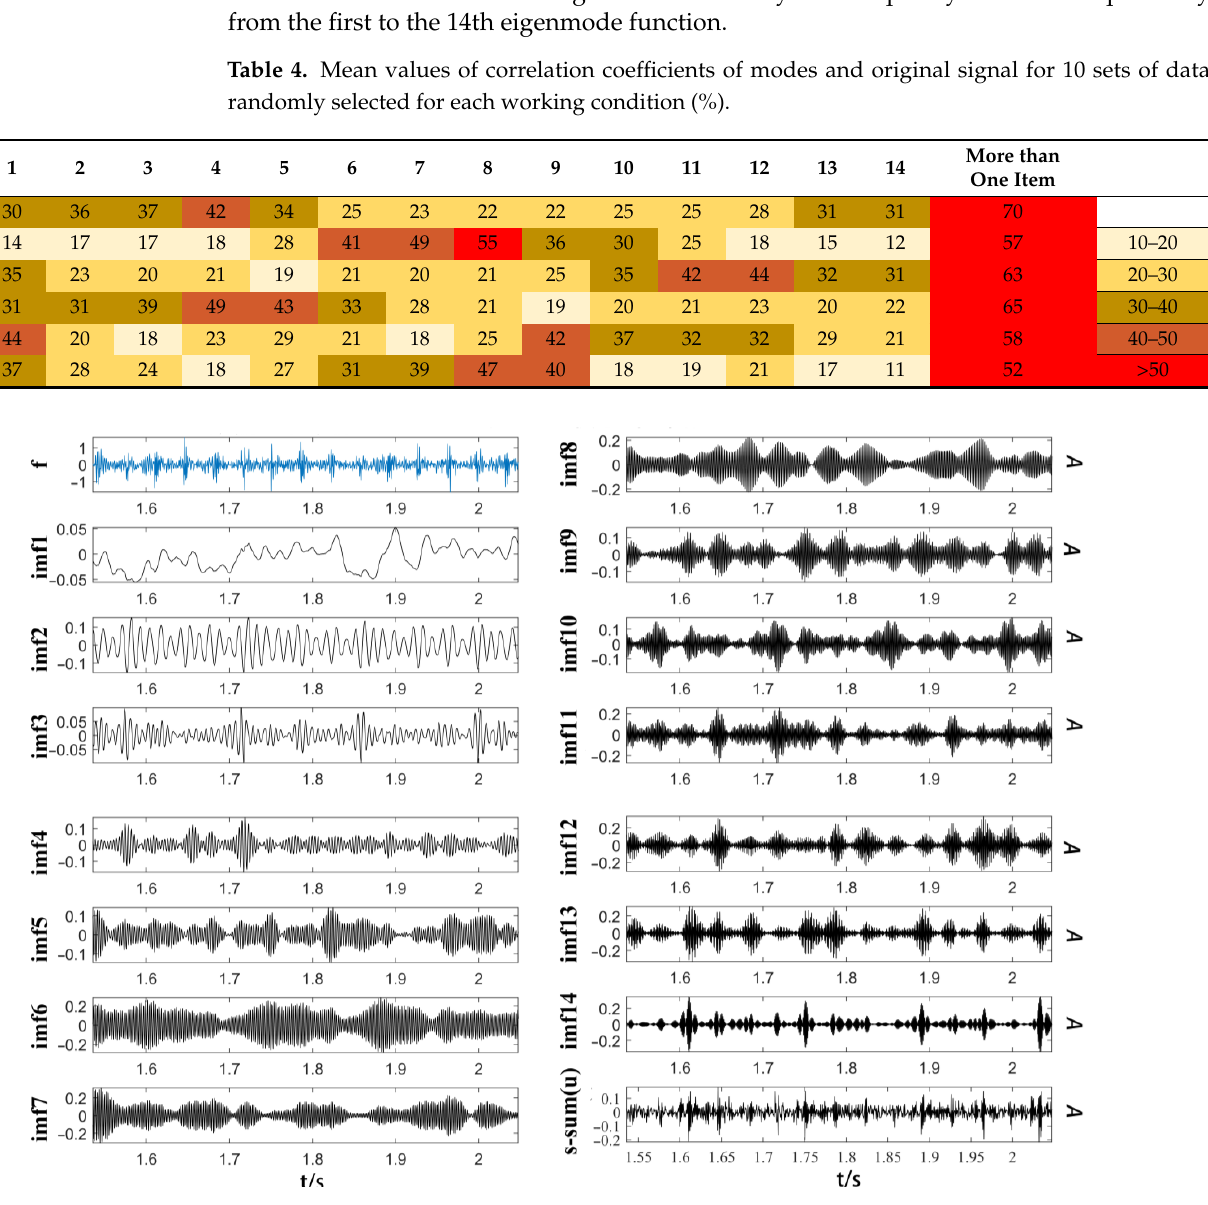
Figure 7. Raw data with eigenmode function and residual term time-domain alignment entropy parameter selection.